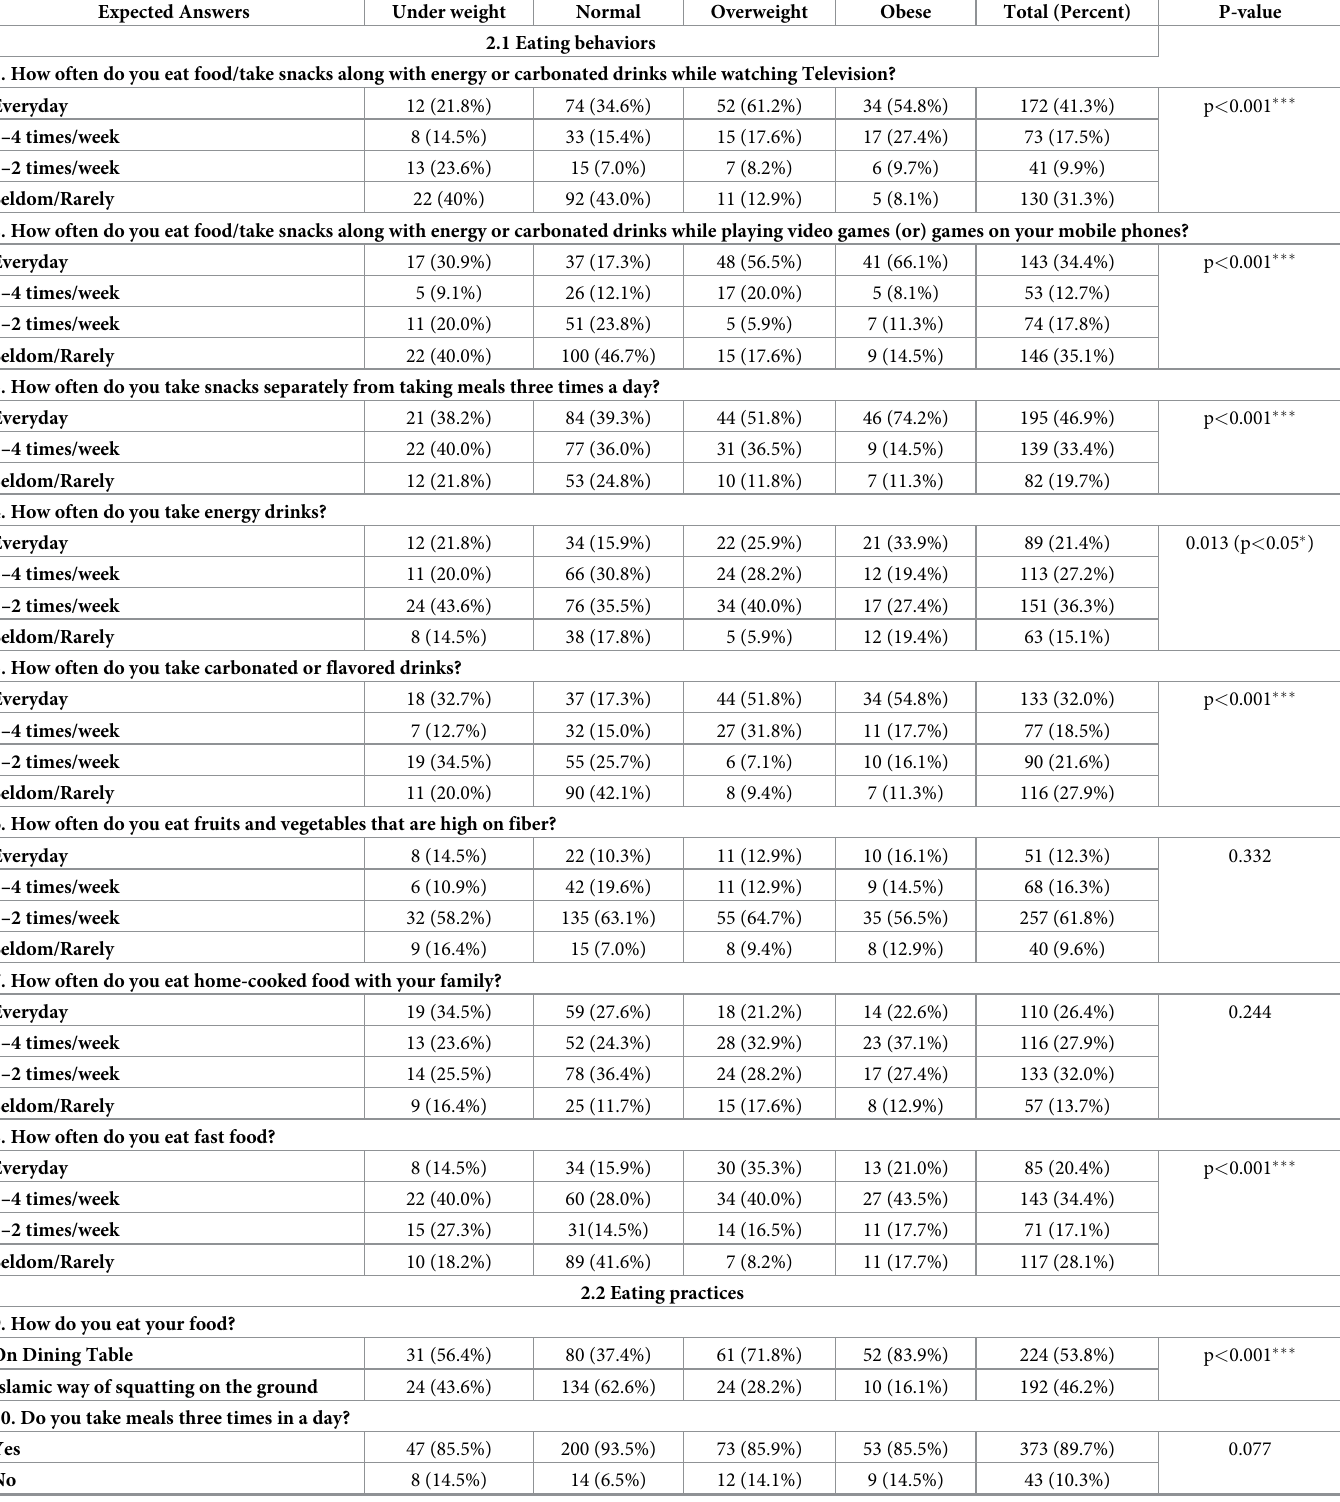
Table 2. Crosstabulation of BMI with eating behaviors, eating practices, and awareness of the health risks associated with